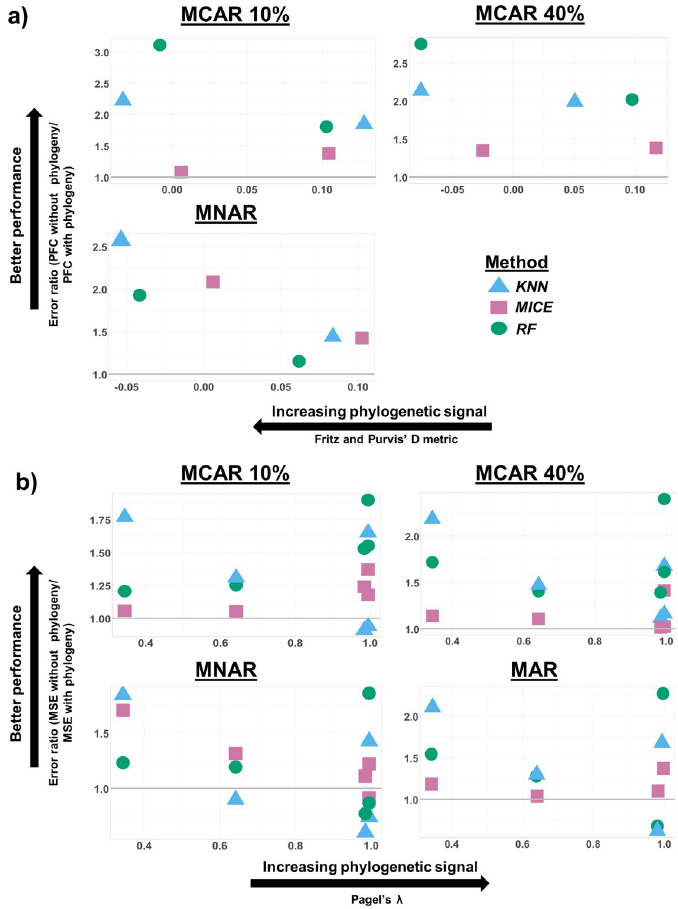
Fig 5. Association between error ratio and phylogenetic signal. Association between error ratio (error rate without phylogeny/error rate with phylogeny) and phylogenetic signal (Fritz and Purvis’ D [41] for categorical traits and Pagel’s λ [42] for numerical traits) at different proportions of missingness. Error ratio values above 1 (indicated by the gray line) signify an improvement in performance when phylogeny is added. In the case of D , lower values are indicative of higher levels of phylogenetic conservation for the trait; conversely, higher values of λ suggest stronger phylogenetic signal. Results are not shown for MAR in a) as only one trait (activity time) was simulated under this mechanism. To improve visualization, values were jittered (random noise introduced to data) using the package “ggplot2” [43]. Additionally, results are only shown for the c-mos gene (categorical traits) and RAG1 gene (numerical traits) as other genes followed similar patterns and these genes displayed the greatest range in phylogenetic